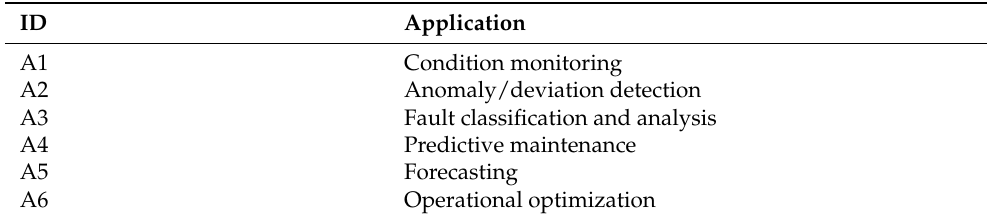
Table 1. Most relevant technical categories of digital applications considered for value creation during operation of industrial energy systems. For an in-depth review, we refer to [11,41,51].